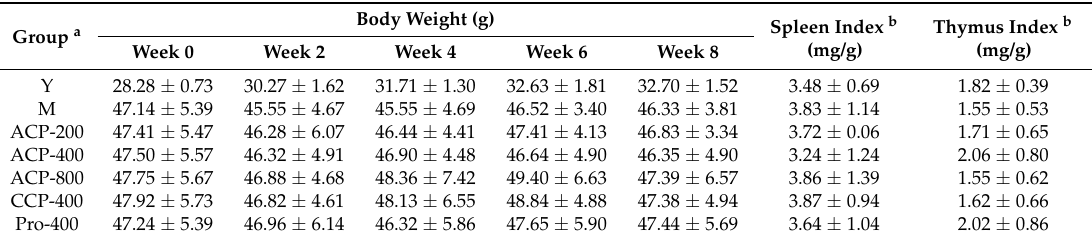
Table 3. Body weight, spleen index (SI) and thymus index (TI) of chronologically aged mice after the administration of collagen peptides for 8